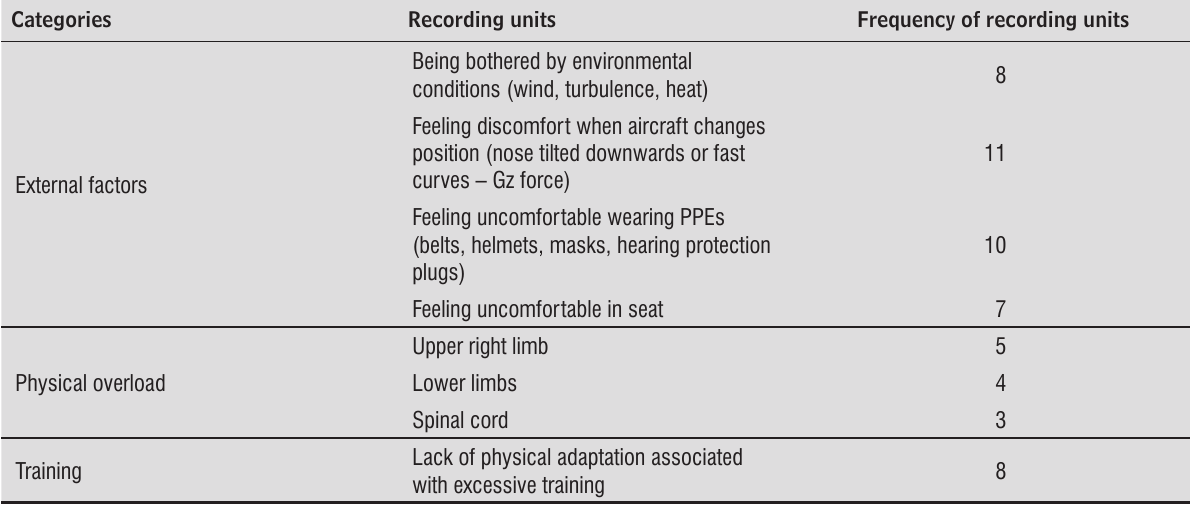
Table 1 - Pilots’ body self-perception in aircraft during